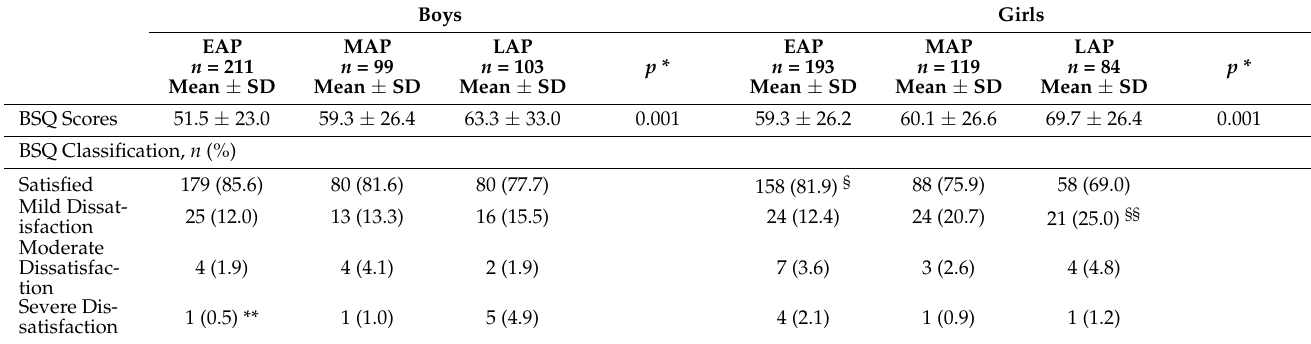
Table 1. Descriptive analysis of the anthropometric variables for periods of